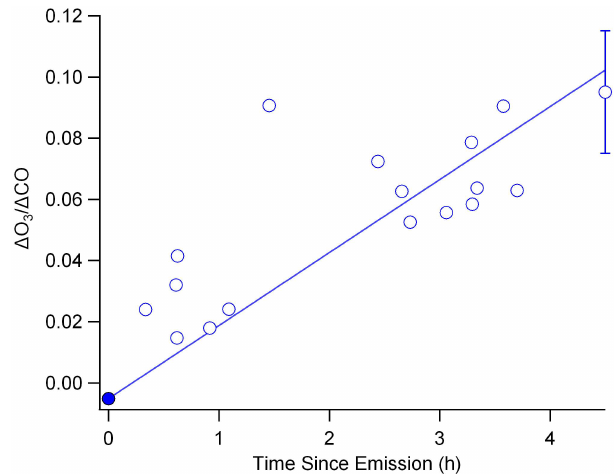
Fig. 5. 1 O 3 / 1 CO vs. time since emission (h). Individual source samples are not shown and we instead show the initial negative 1 O 3 / 1 CO NEMR (solid circle). The error bar reflecting the stan- dard deviation in the mean of the ten source measurements is too small to be visible. The downwind error bar is an estimate of the uncertainty in the oldest individual downwind